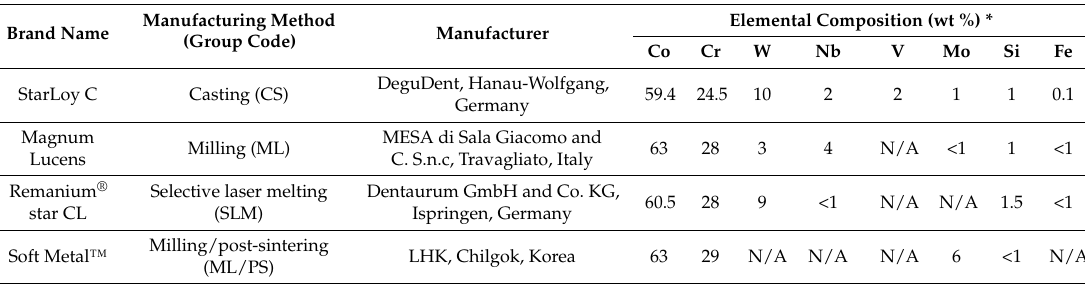
Table 1. Brand names, manufacturing methods, manufacturers, and elemental compositions of the four Co-Cr alloys tested.